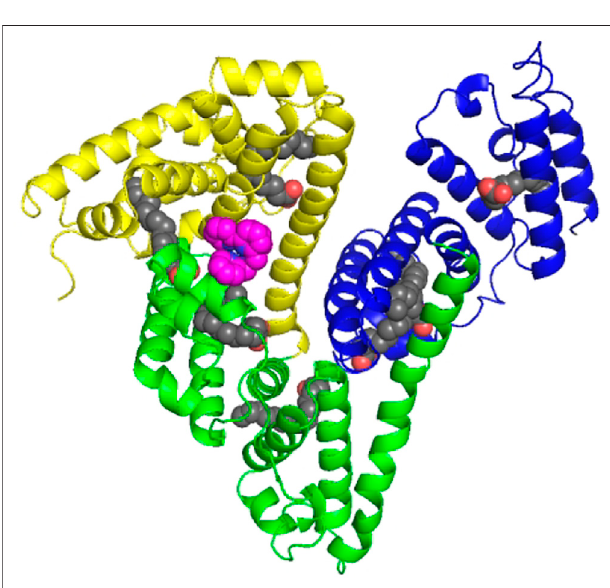
FIGURE 5 | Cartoon representation of the overall structure of HSA and Fe complex adduct. Every domain is differently colored (domain I, yellow; domain II, green; and domain III, blue). The Fe complexes are represented as spheres in pink. The seven palmitic acid (PA) molecules bound to HSA are displayed as sphere chains (aliphatic chain, gray spheres; carboxylate oxygens, red spheres).